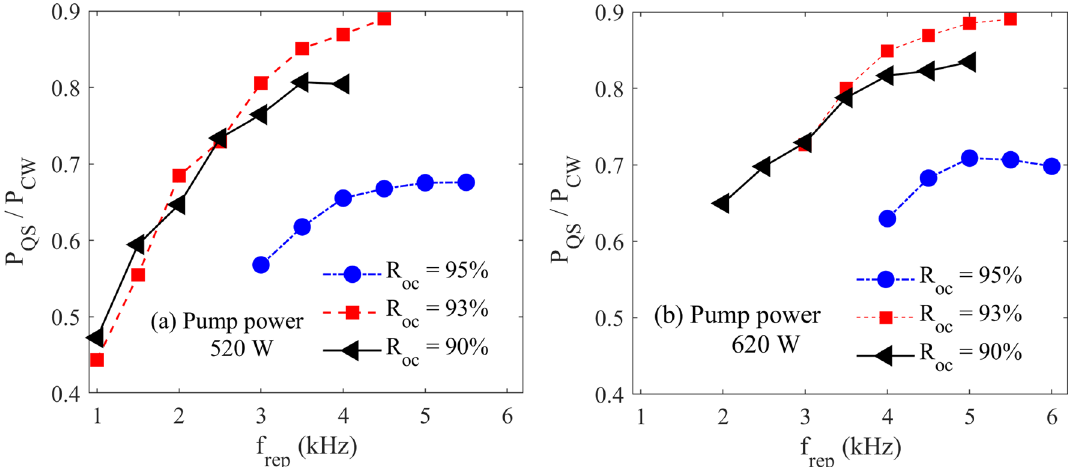
Figure 3. The pulsed to CW average power ratio versus repetition rate for different OCs and two pump powers of 520 and 620 W.